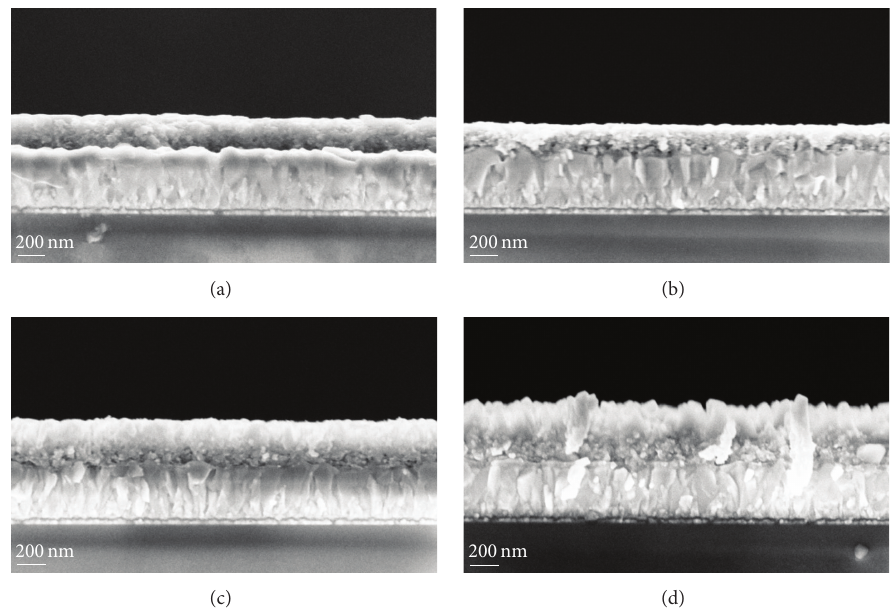
Figure 3: Cross-sectional SEM images of PbI 2 layer deposited on the mp-TiO 2 coated FTO substrate, where the substrate was preheated at (a) room temperature and (b) 70 ∘ C, and MAPbI 3 films formed by deposition of MAI on the PbI 2 layer were fabricated at substrate temperatures of (c) room temperature and (d) 70 ∘ C.